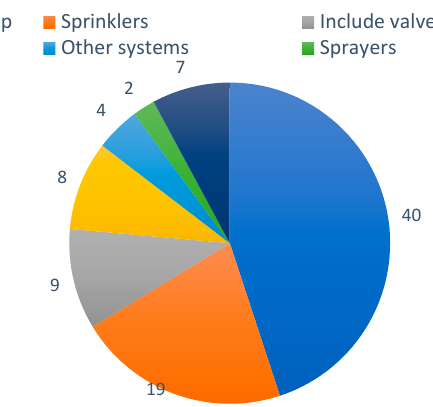
Figure 3. Number of papers that propose different irrigation systems.